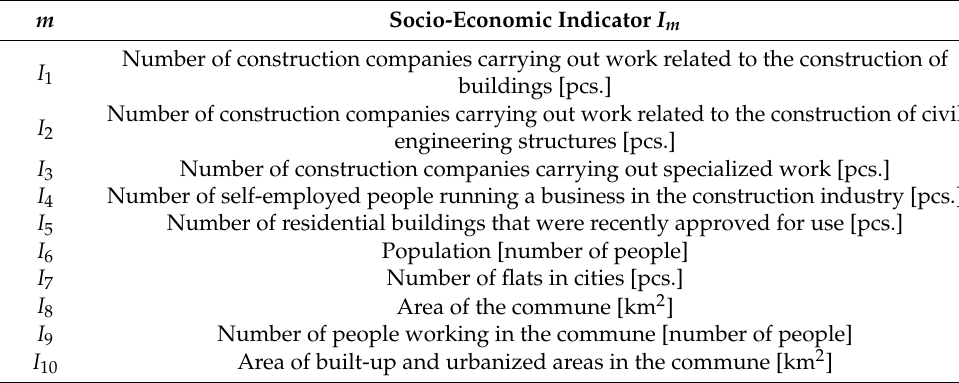
Table 1. Socio-economic indicators I m .